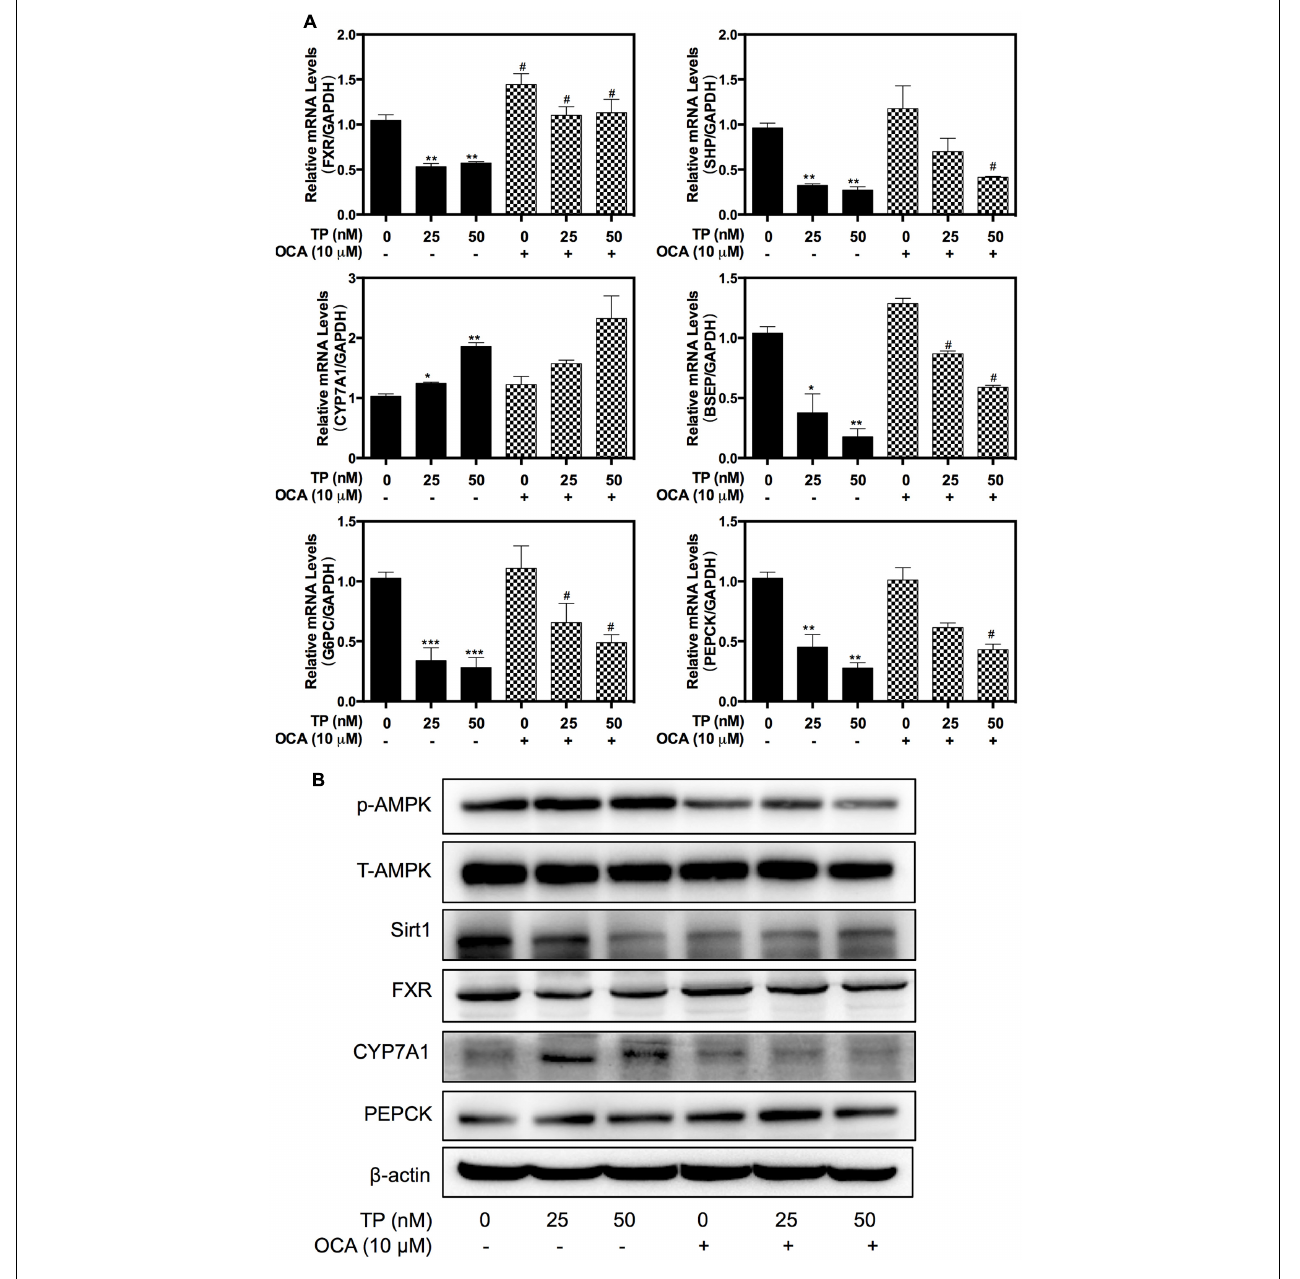
FIGURE 4 | Role of FXR in TP-induced hepatotoxicity. Primary rat hepatocytes were pretreated with the FXR agonist, obeticholic acid (OCA) (10 µ M), for one hour and then treated with TP for 8 h. (A) The mRNA levels of FXR-target genes were determined using real-time RT-PCR and normalized to GAPDH as an internal control. (B) The target protein levels were determined using western blot analysis and normalized to β -actin as a loading control. Statistical significance relative to vehicle control, ∗ p < 0.05, ∗∗ p < 0.01, ∗∗∗ p < 0.001; and statistical significance relative to the corresponding treated groups without OCA, # p < 0.05, ## p < 0.01, ### p <